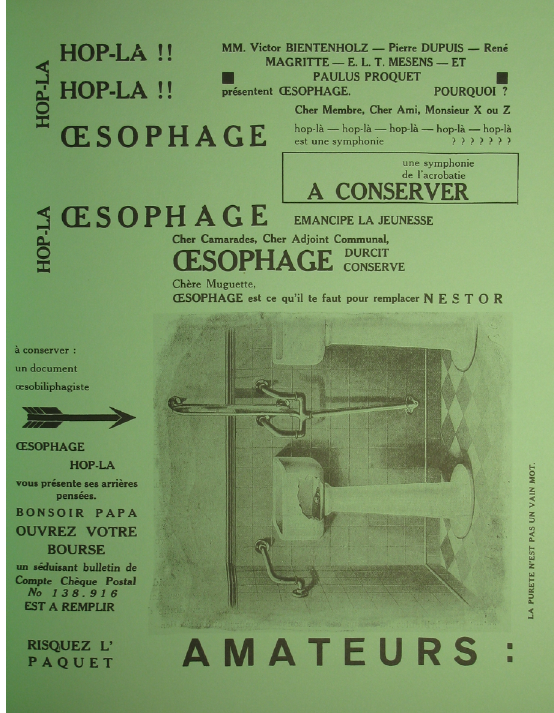
Fig. 9 Œsophage , no. 1 (March 1925), last